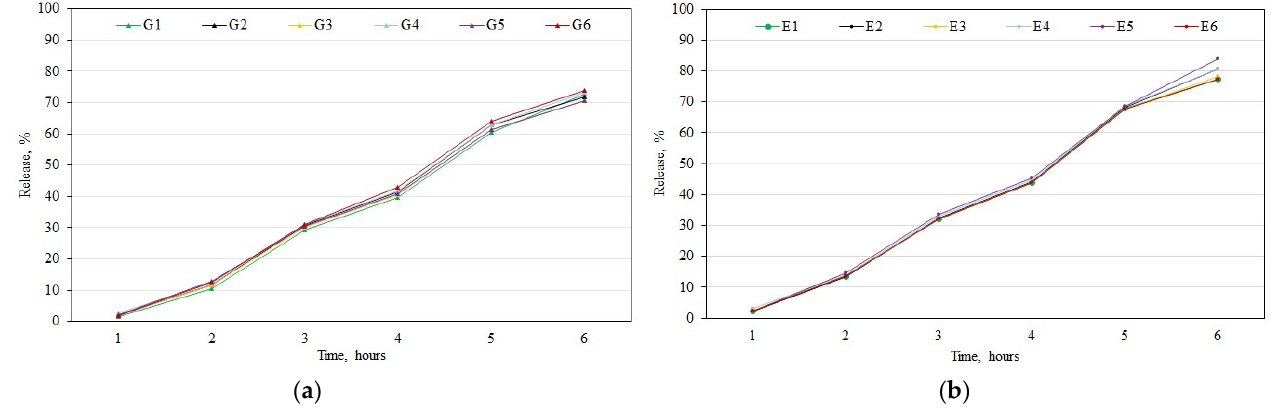
Figure 2. Percentage release of total phenolic compounds: ( a ) Percentage release of total phenolic compounds from gels G1–G6 after 6 h; ( b ) percentage release of total phenolic compounds from emulgels E1–E6 after 6 h (mean ± SD, n = 3).